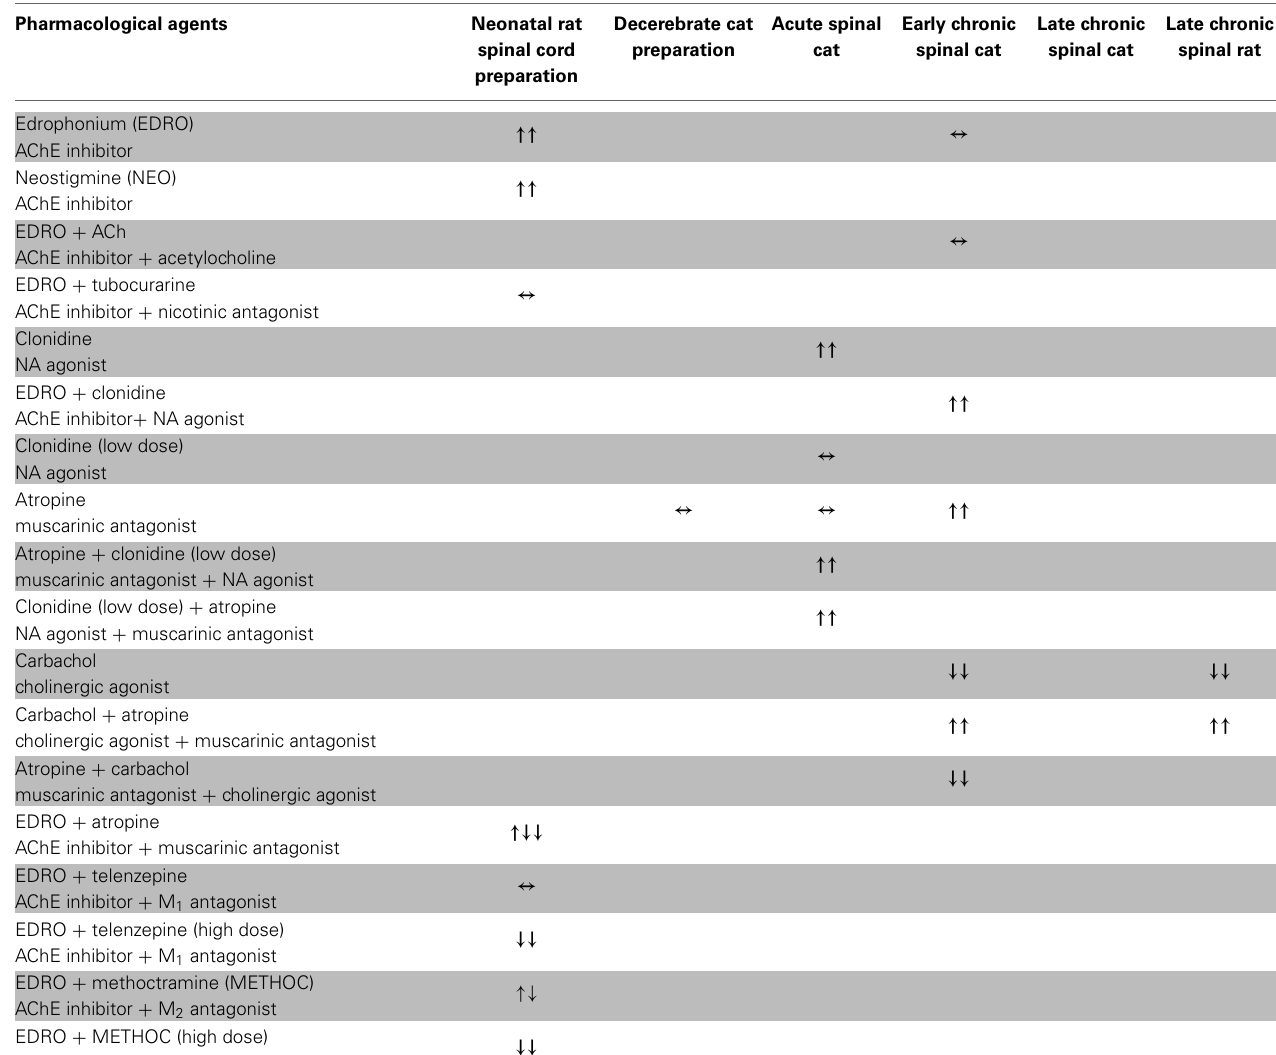
Table 1 | Summary of the effects of drugs altering cholinergic function in the various preparations used in this study. Pharmacological